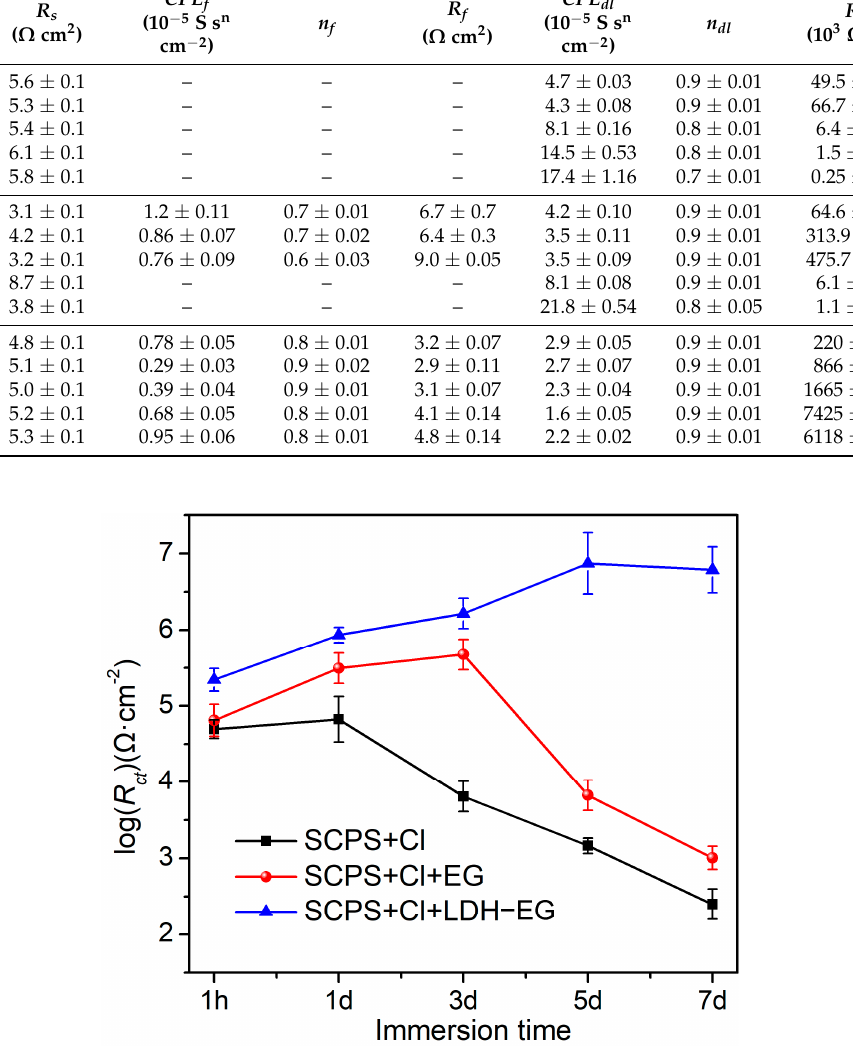
Figure 9. The time-dependent behavior of R ct .